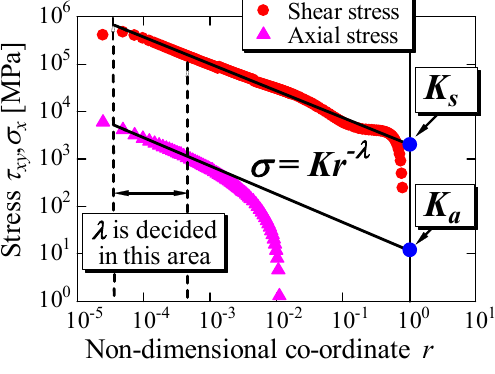
Figure 12. Determination of K and λ on the stress distributions at the stress singularity